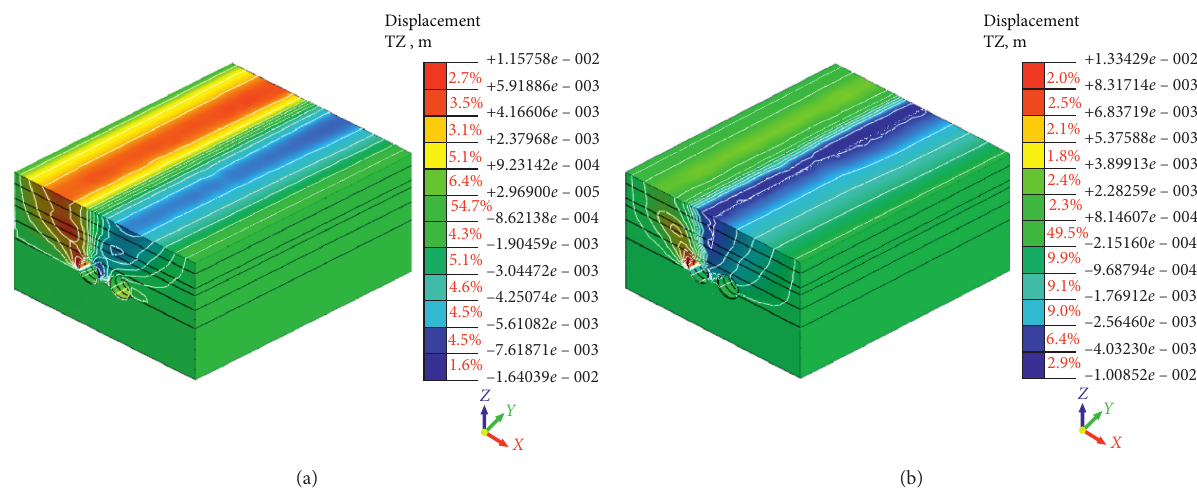
Figure 12: Horizontal displacement nephogram of strata before and after reinforcement. (a) Horizontal displacement nephogram of unconsolidated strata. (b) Horizontal displacement nephogram of consolidated strata.